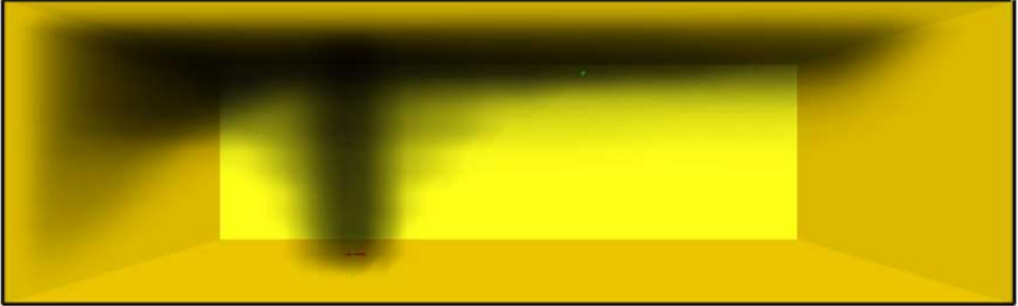
Figure 6. Soot concentration field created by Heptane jet fire at t = 5.8 s.